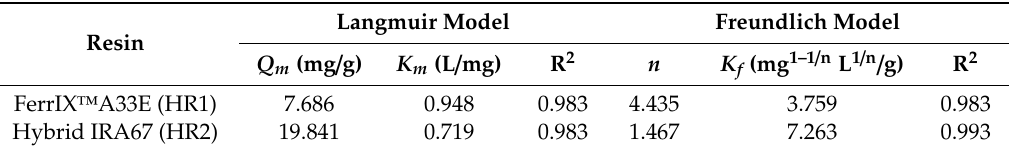
Table 2. Parameters of isotherm models in phosphate adsorption by hybrid resins. Q m and K m represent the maximum adsorption (mg / g) and a parameter related to the bonding strength (L / mg) in the Langmuir model, respectively. K f and n are a parameter related to the adsorption capacity and a parameter related to the intensity of adsorption in the Freundlich model, respectively.